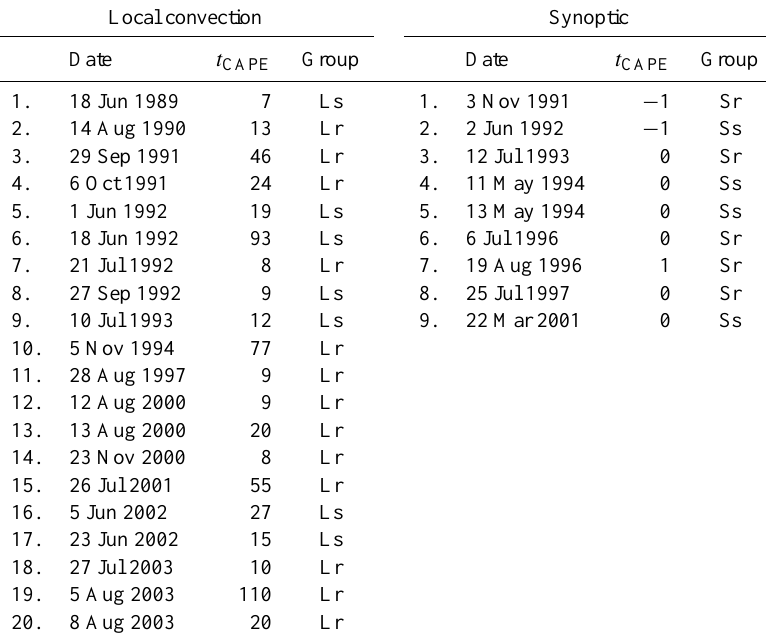
Table 3. Classification of the flash events in the calibration period 1989–2003. The list contains the date of event, the t CAPE value, and its category: Ls – local rainfall, spring Lr – local rainfall, summer, Ss synoptic rainfall, spring, Sr synoptic rainfall,